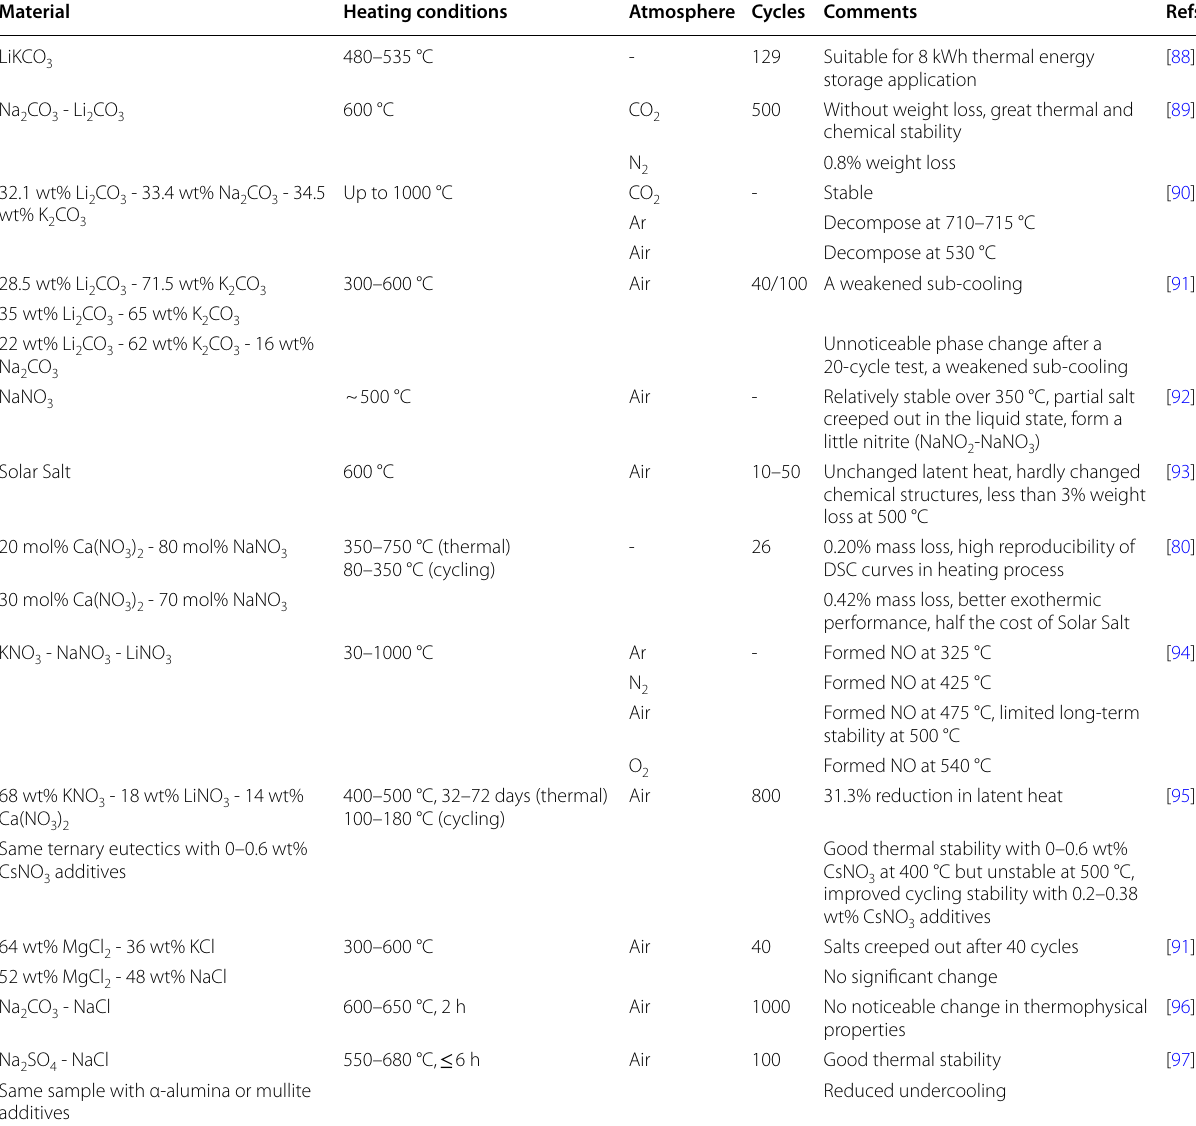
Table 6 Representative studies of the cycling and thermal stability of carbonates, nitrates and chlorides